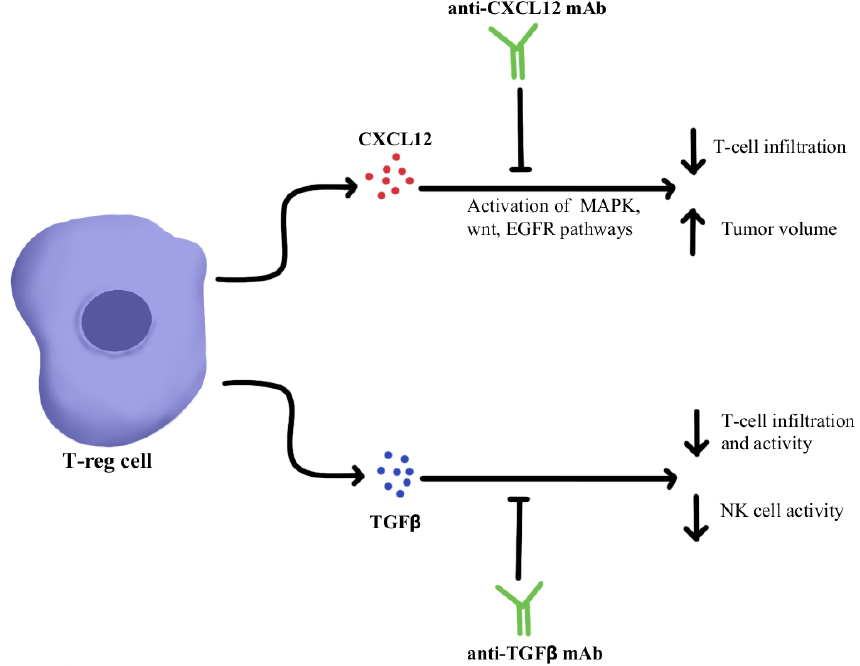
Figure 1. Diagram of CXCL12 and TGF β cytokine pathway modulation [48–59]. Illustrated by Kaitlyn Mi of The Dartmouth Institute.